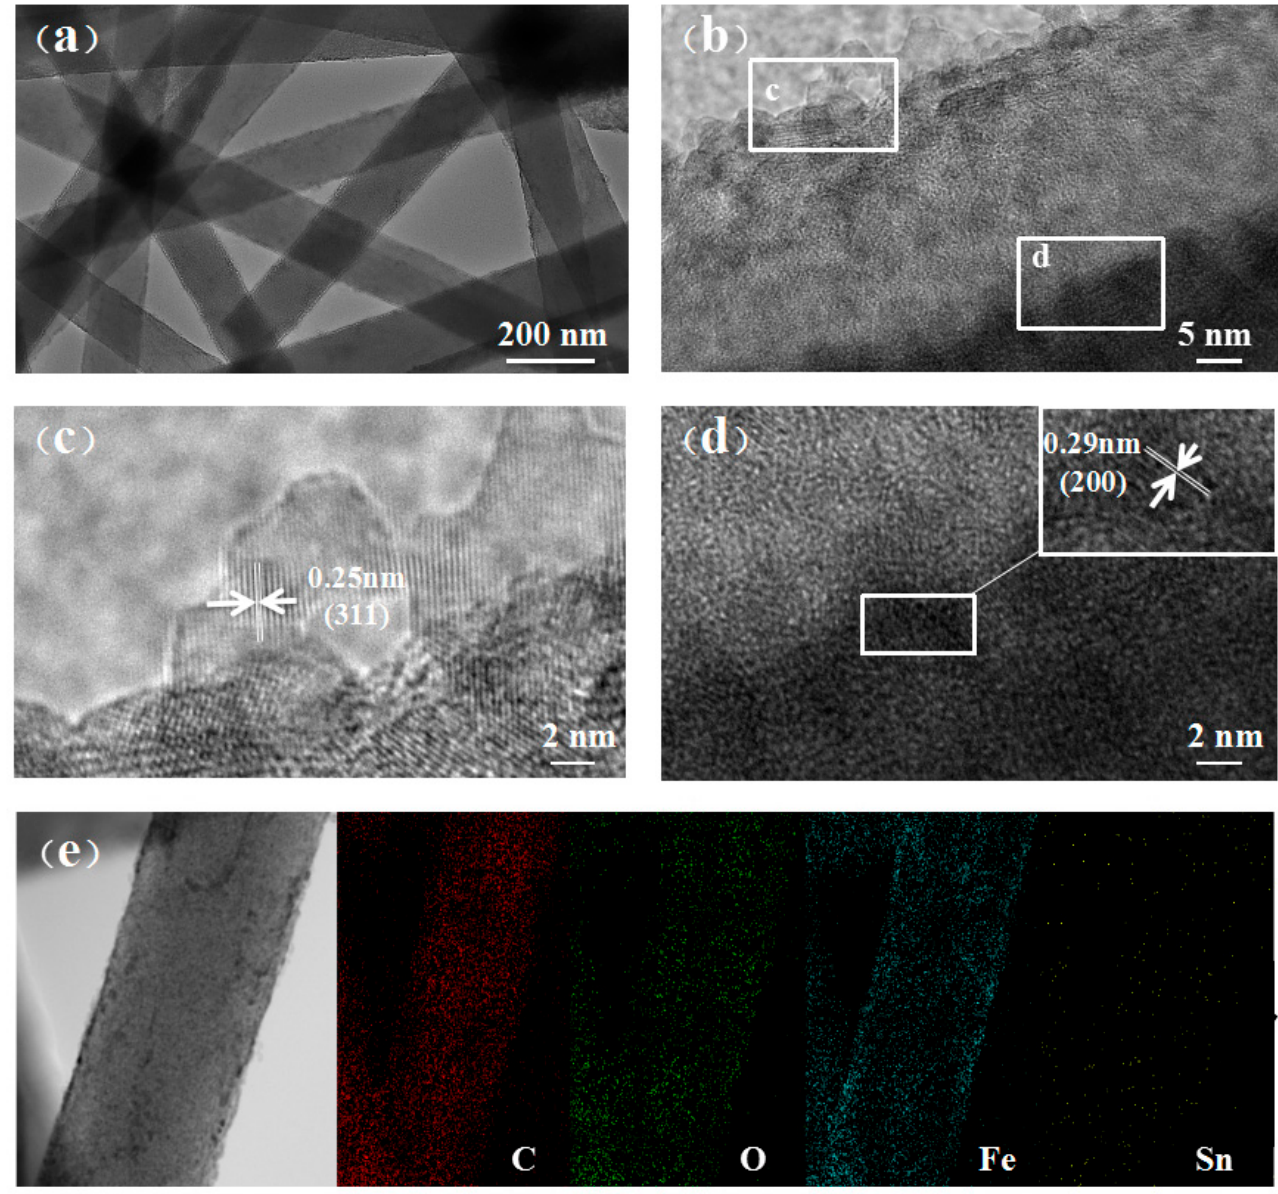
Figure 4. ( a – d ) The TEM images and the high-resolution TEM image of Fe 3 O 4 -Sn@CNFs. ( e ) Mapping diagram of elements contains four elements.